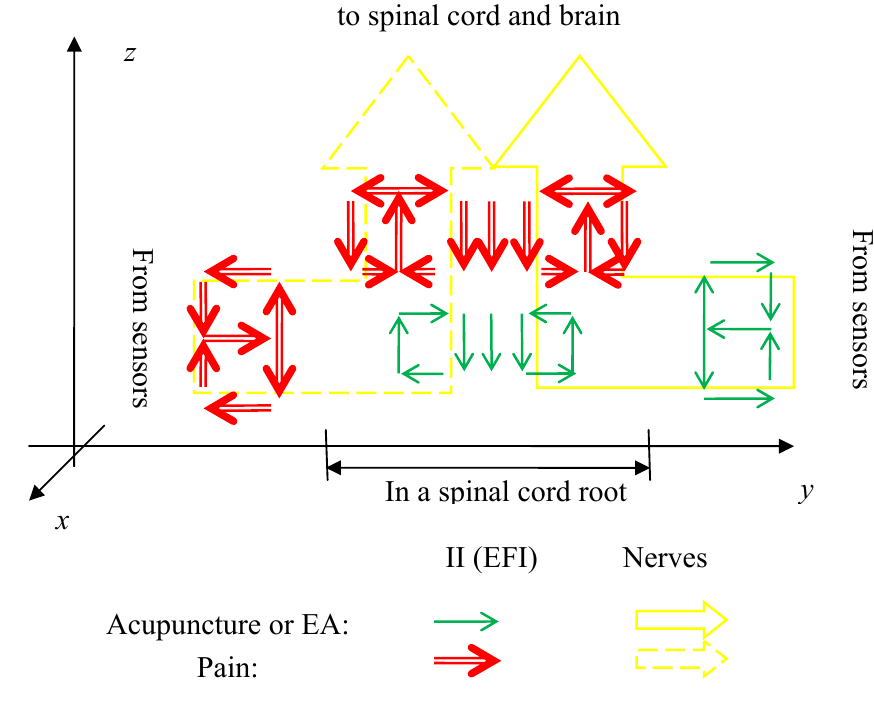
Figure 4. Our model of the nervous II (EFI) of pain and acupuncture (or EA) in a spinal cord